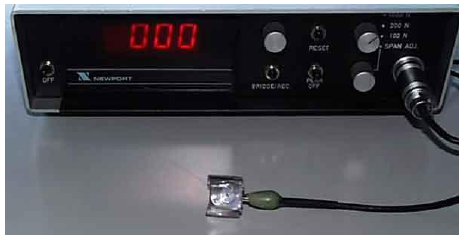
Figure 2. A photograph of the miniature pressure transducer used for the measurement of the bite force.